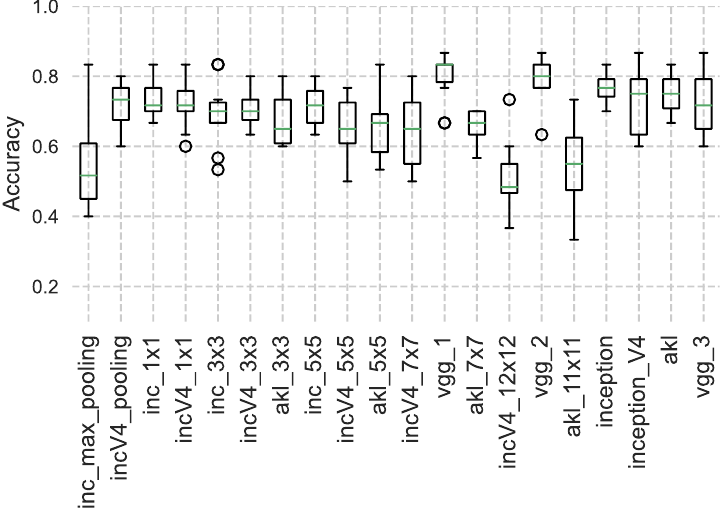
Figure 10. K-NN results using the Horse vs. Human dataset. The performance of the larger kernels, i.e., incV4_12 12 and akl_11 11, is low compared to the other kernels for the images of smaller size. × ×